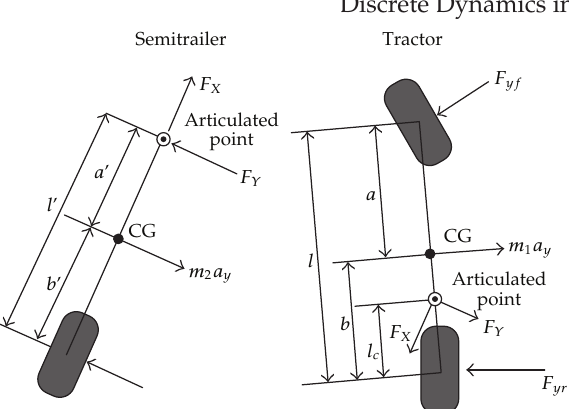
Figure 1: Representation of tractor semitrailer: main dimensions and lateral